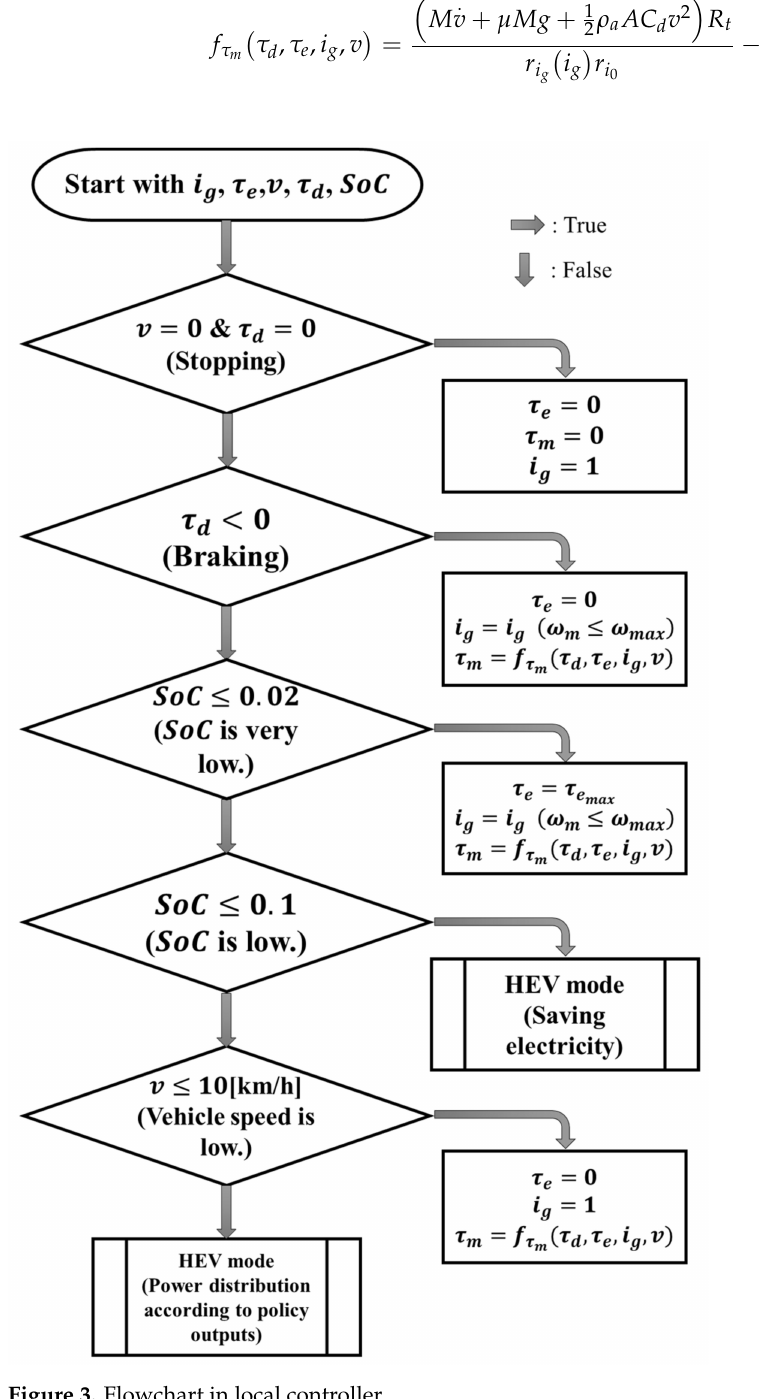
Figure 3. Flowchart in local